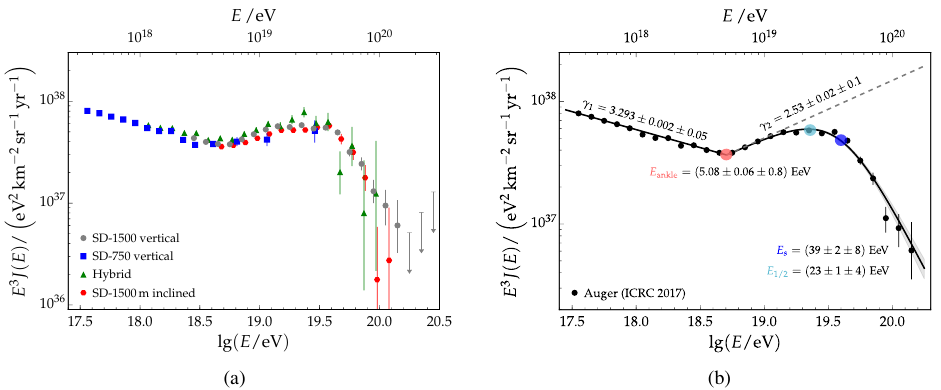
Figure 2: (a) Energy spectra obtained from the three SD data sets and the hybrid data. The systematic uncertainty on the energy scale, which is common to all of them, is 14%. (b) Combined spectrum and fitted function. The optimal parameters are given in